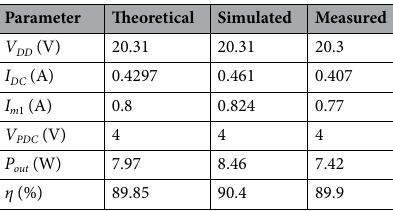
Table 4. The important parameters of the inverter at 25